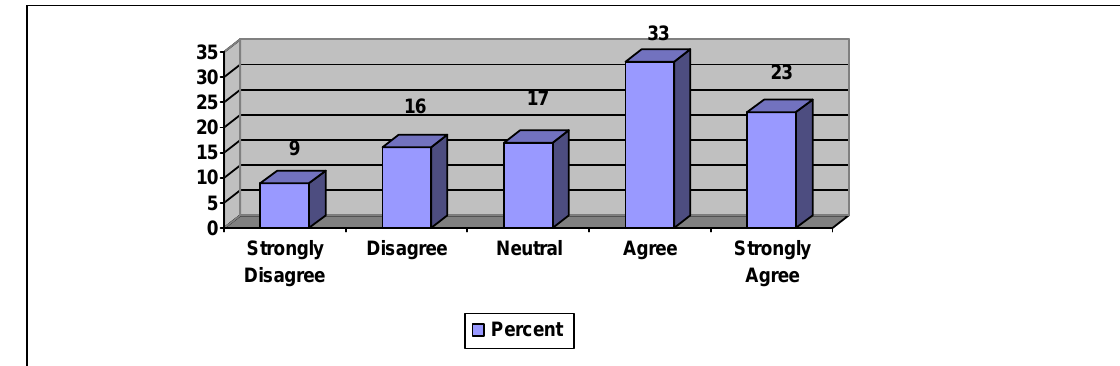
Percent of respondents who indicated their satisfaction with staying in a 4-H career with